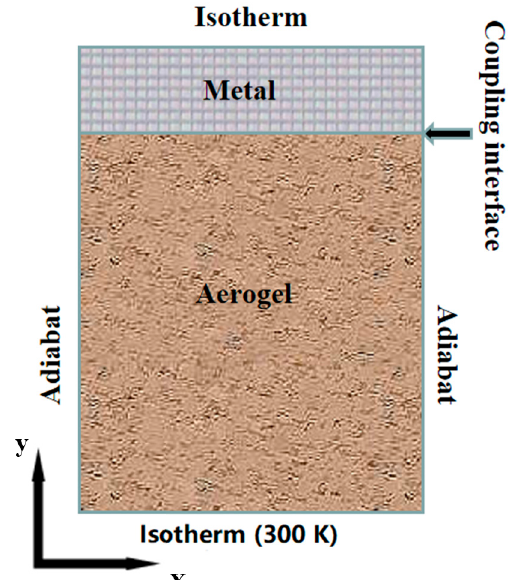
Figure 7. Schematic diagram of computation domain. Table 1. The calculation conditions.